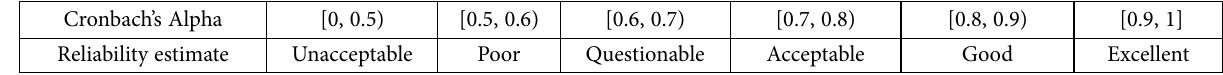
Table 3. The scales of Cronbach’s Alpha coefficient for reliability estimate Cronbach’s Alpha